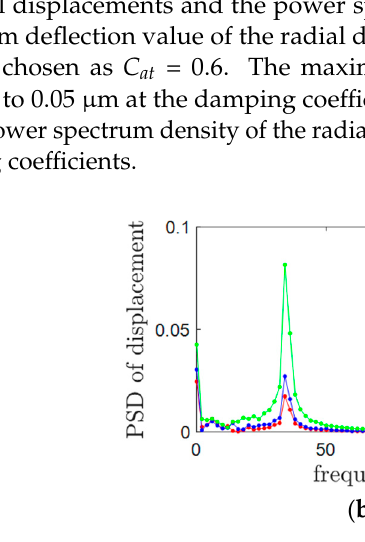
Figure 12. The vibration characteristics of the 5 − DoF MSMW when the rotating speed is 2000 rpm. ( a ) The radial displacement of the flywheel rotor at 2000 rpm. ( b ) The power spectrum density of the radial displacement at 2000 rpm.